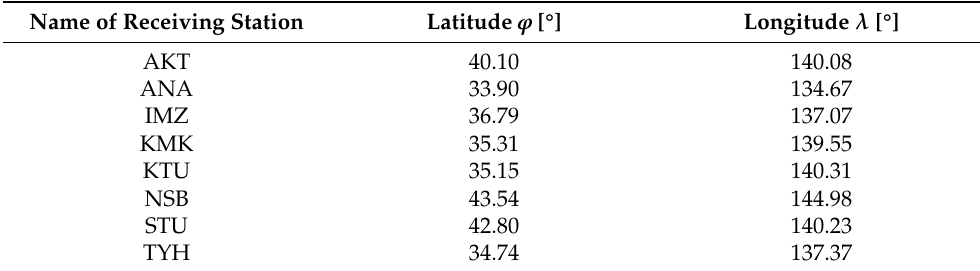
Figure 1. Diurnal variations of the JJI transmitter VLF signal amplitude: observations at TYH station on 15 March, 15 June, 15 September, and 15 December 2015 ( a ); NSB and TYH stations, 15–18 March 2015 ( b , c ). Amplitude values are in decibels. The location of the transmitter and eight receivers is shown in ( d ). Table 1. List of receiving stations in